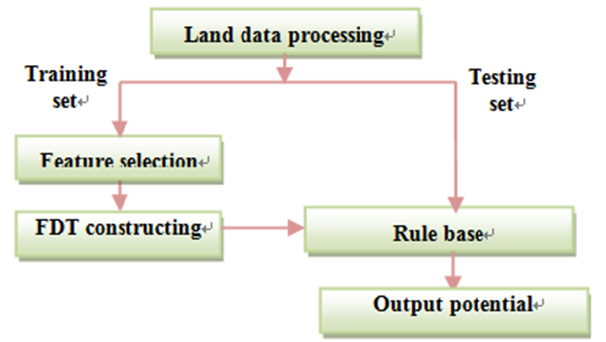
Figure 2. Flowchart of the model